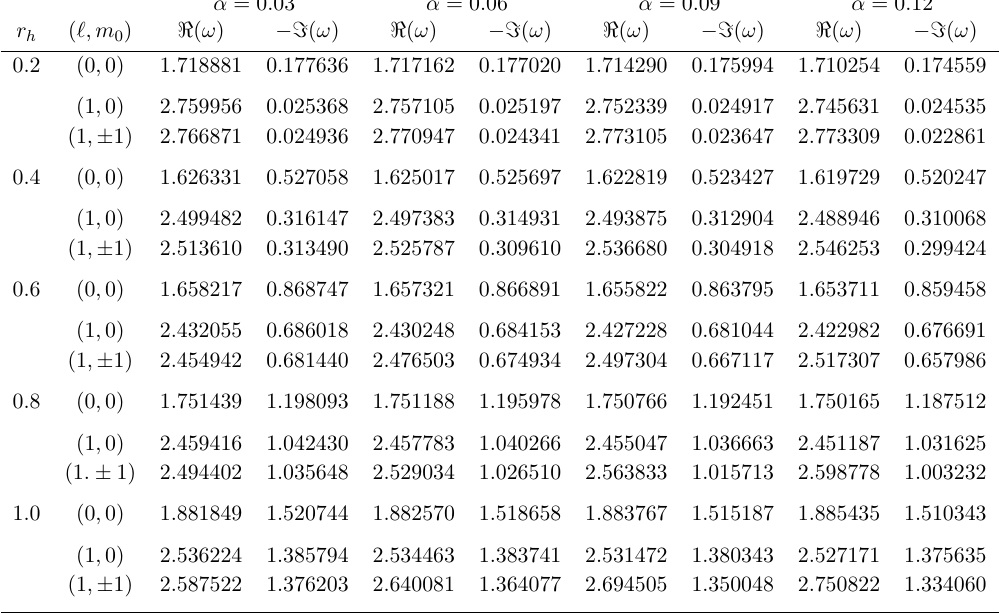
Table 3 . Quasinormal modes of the ARNAdS black holes with Λ = − 3 and Q = 0 . 1 .